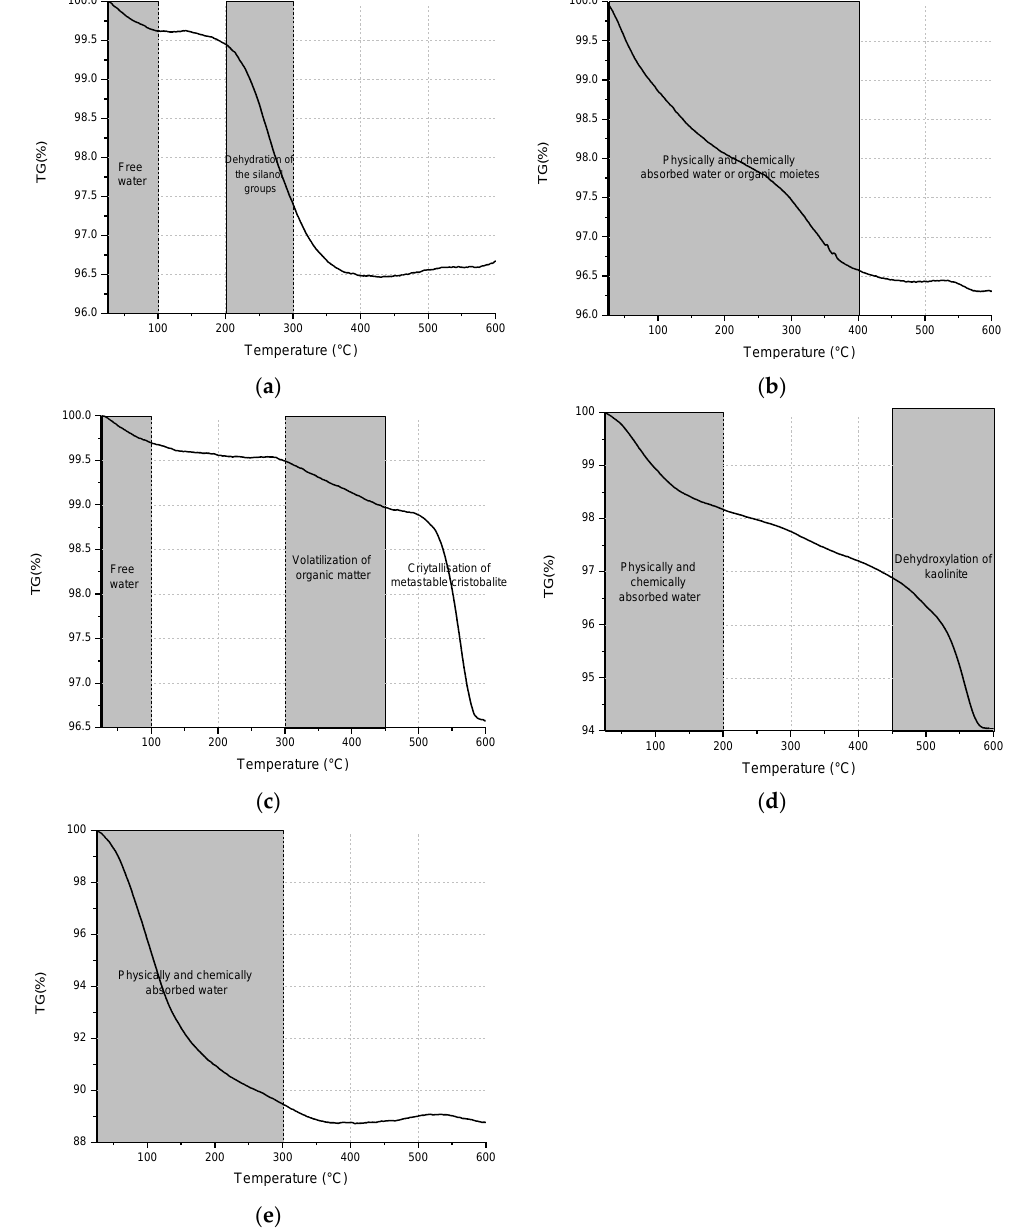
Figure 4. Thermogravimetric analysis of ( a ) SF, ( b )SCBAM, ( c ) SCBAMH, ( d ) MK, and ( e ) BFS